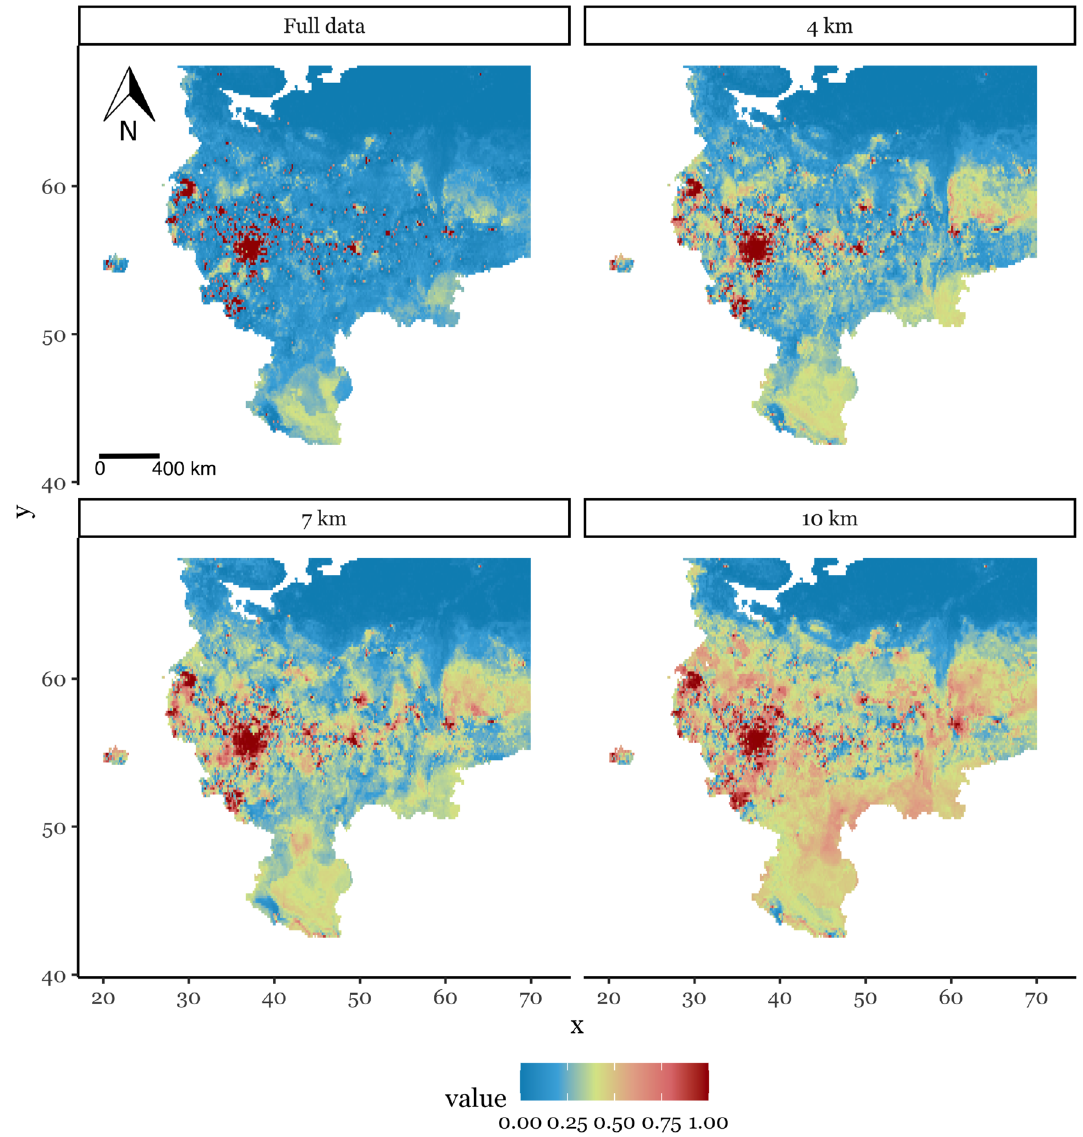
Figure 2. Maps of prediction of possible distribution of HS in current climate conditions using different thinning distances and, consequently, amounts of input points. The quality of prediction varies significantly, while the model built on the full dataset is obviously